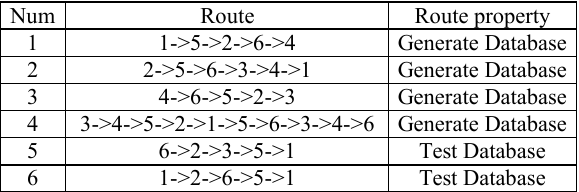
Figure 6 . The Movement Routes (a) Generate Database Routes (b) Test Database Routes The specific roadmap is shown in Table 4. Table 4 . The Routes of Generating Database and Test Database